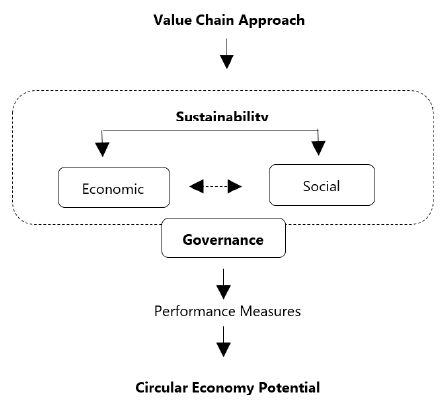
Figure 1. Sustainability assessment framework for an agri-food value chain.